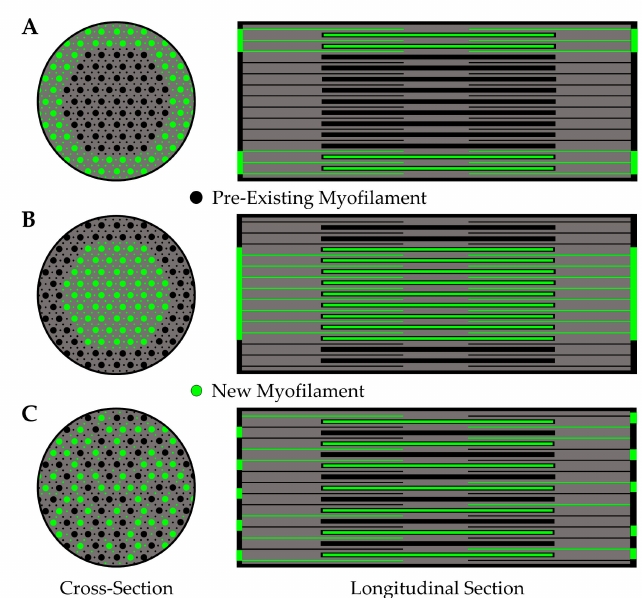
Figure 9. Illustration of where new myofilaments might be added during myofibril hypertrophy. The described possibilities include: ( A ) the periphery of the pre-existing myofibril, ( B ) the center of the pre-existing myofibril, or ( C ) throughout the pre-existing myofibril.